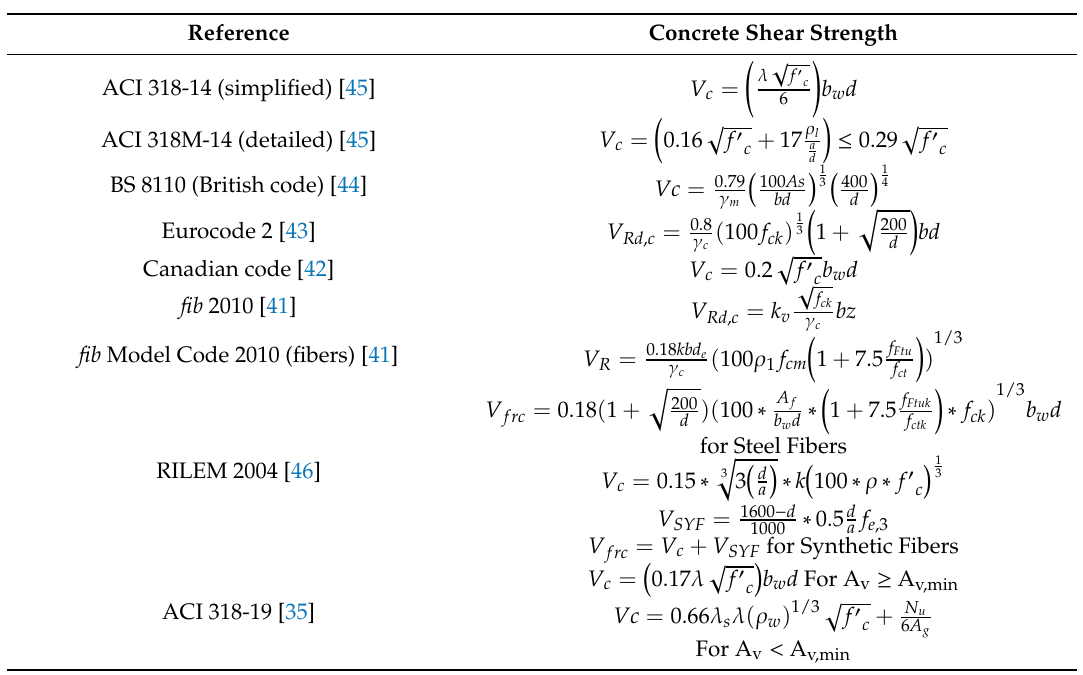
Table 2. Equations for v c from common code of practice